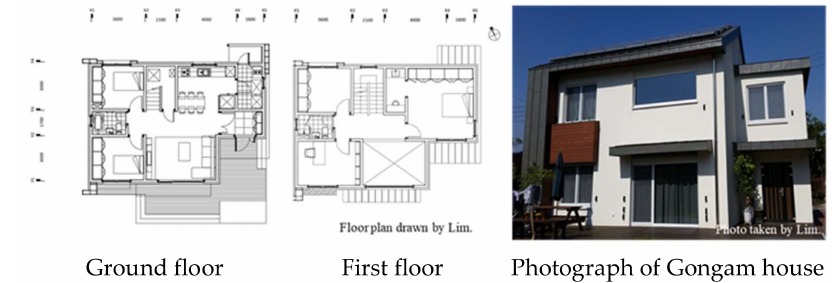
Figure 1. Floor plan and south view of Gongam house.